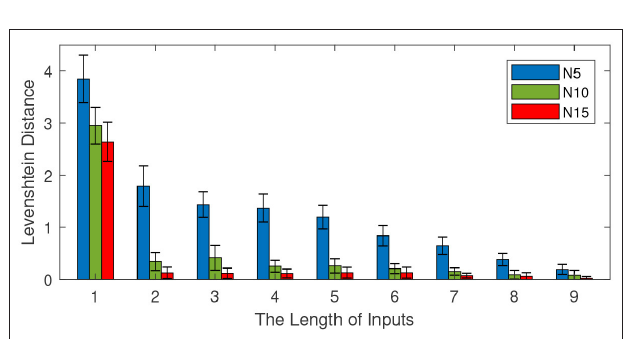
FIGURE 9 | Effect of the input length on memory retrieval performance. The number of total sentences is 100 and the number of neurons in each column is 5, 10, and 15. The length of inputs varies from 1 to 9 with an interval of